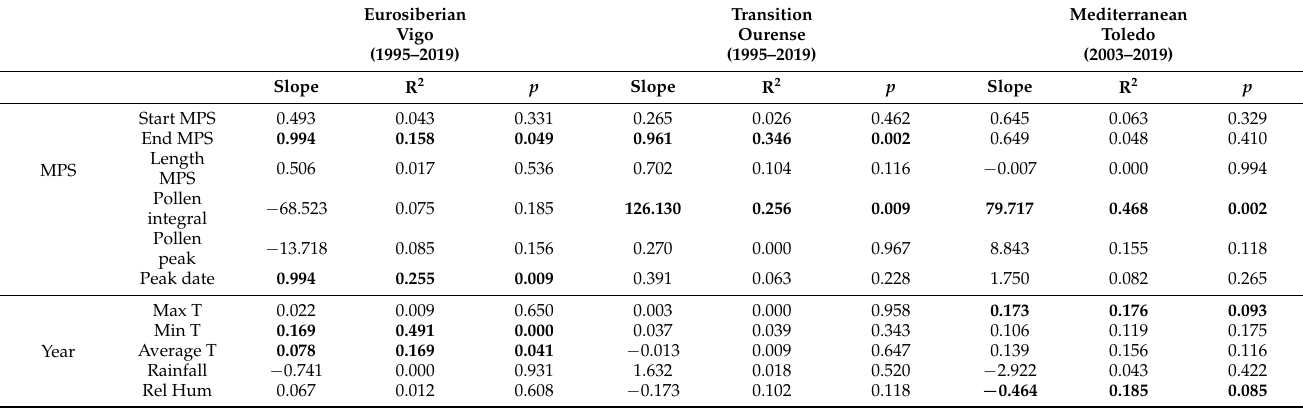
Table 5. Trends of the MPS characteristics (start, end and length dates of the MPS, pollen integral, pollen peak concentration and pollen peak day) and meteorological variables (maximum, minimum and average temperatures, total rainfall and relative humidity). The shown parameters of the linear regression analysis are slope, R 2 value and p -value. The significant results are shown in